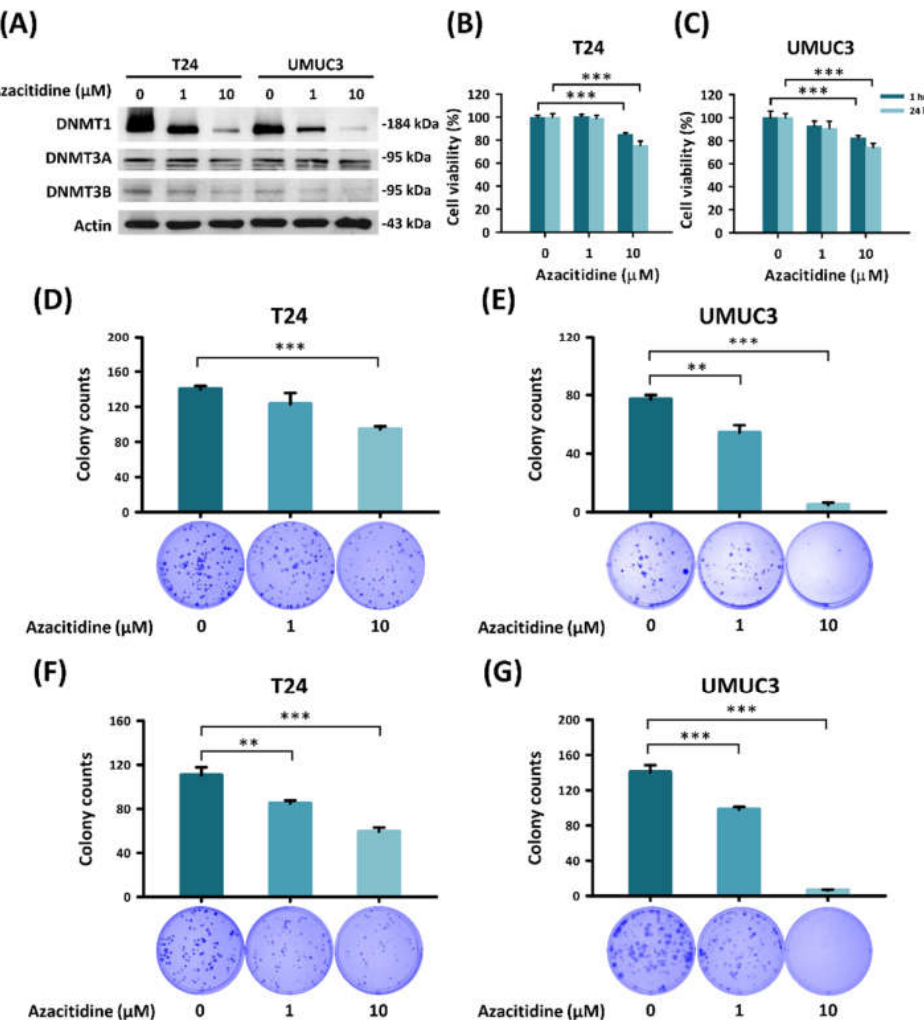
Figure 1. Azacitidine inhibits cell viability and clonogenic activity of UBUC cell lines. ( A ) Azacitidine inhibited DNMT1 expression. Expression of DNMT family proteins in UBUC cells treated with azacitidine (0, 1, and 10 µ M) was examined by immunoblotting. ( B , C ) Azacitidine reduced cell viability of T24 and UMUC3 cells, as determined by the MTT assay. ( D – G ) Azacitidine inhibited colony formation by T24 and UMUC3 cells. Colony formation assays were conducted to measure cell growth changes in T24 and UMUC3 cells treated with azacitidine for 3 days ( D , E ) or 10 days ( F , G ) and harvested on the 10th day. Data for colony counts are presented in the upper panel. Data are shown as mean ± s.d (* p < 0.05; ** p < 0.01; *** p < 0.001).